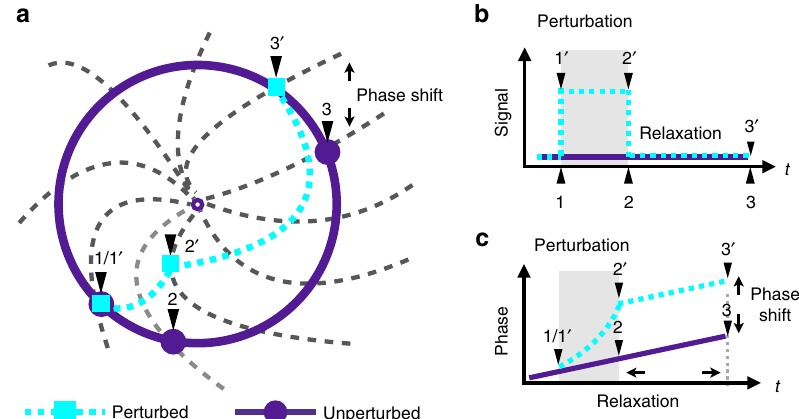
Fig. 1 Illustration of the phase response in biological oscillators. a The circle is the assumed stable limit cycle. The gray dashed lines represent equally separated isochrons. An unperturbed system (purple) progresses on the circle, while a perturbed system (cyan) is driven away from the circle by an impulsive signal between time 1 and time 2, and then relaxes back to the limit cycle. At time 2 (end of perturbation), it is moved to an isochron different from the unperturbed one. The difference of their phases determines the phase shift. b , c Diagrams of the signal and phase evolution of the perturbed and unperturbed system. Phase shift is induced during the perturbation and sustains after the